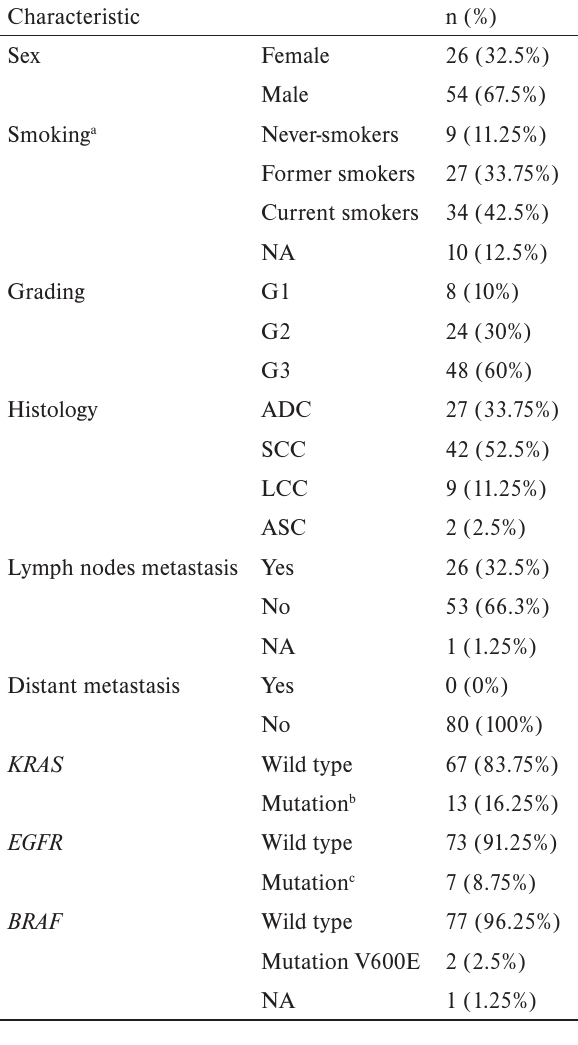
Table 1. Clinicopathological characterization of 80 patients with primary non-small cell lung